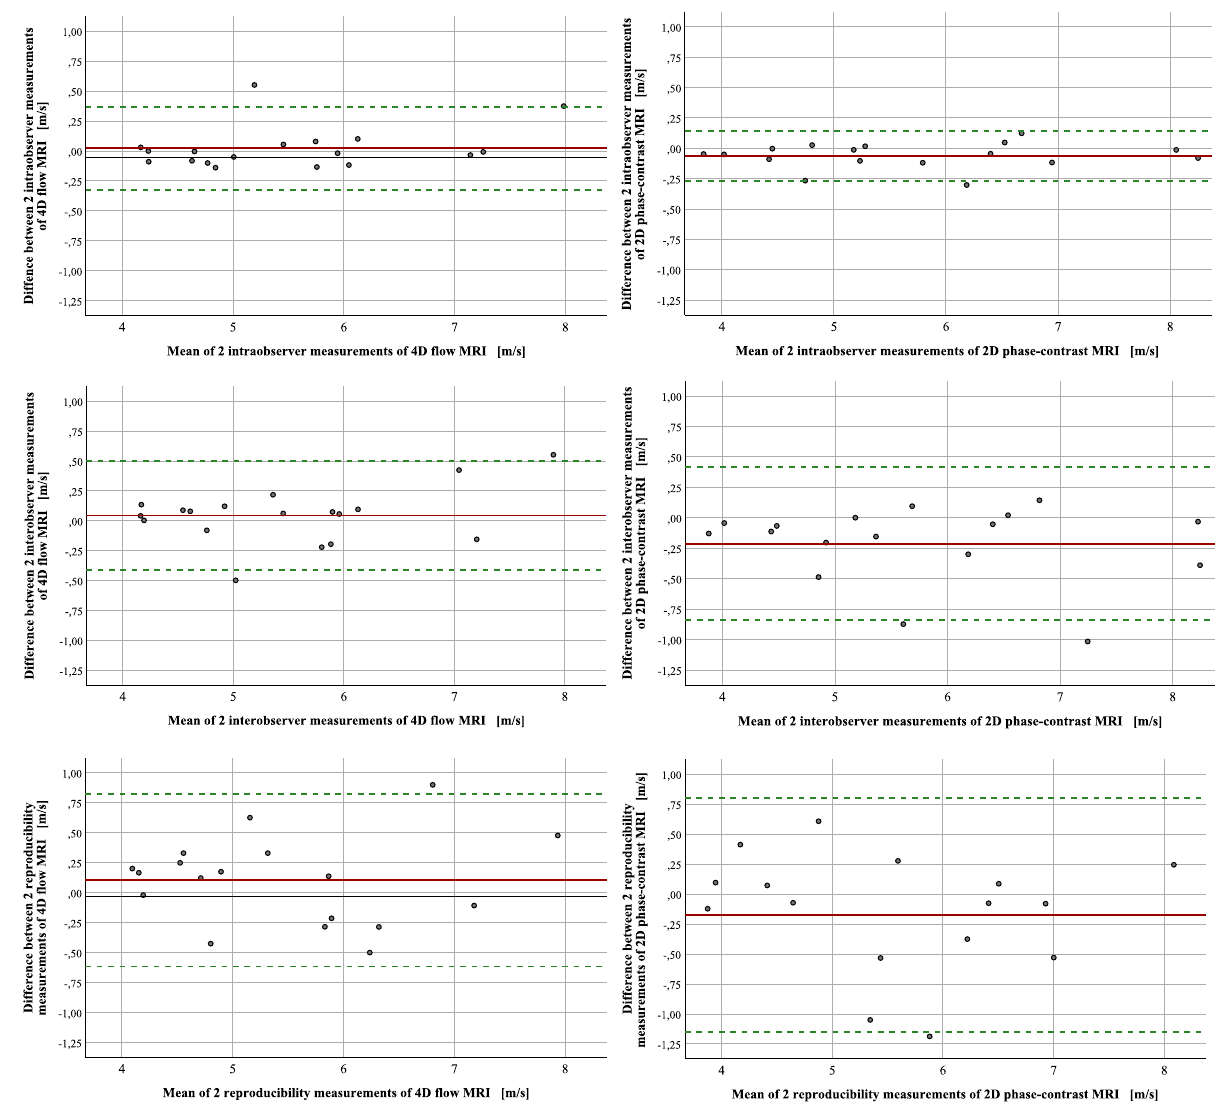
Figure 6. Measurement accuracy of PWV based on 4D flow and 2D phase-contrast MRI. Mean difference (solid line) ± 1.96 × standard deviation (dashed lines) is shown. Intra-observer agreement of 4D flow MRI (left column, n = 18) was 0.02 m/s [−0.32; 0.37], inter-observer agreement of 4D flow MRI was 0.04 m/s [−0.41; 0.5] and reproducibility of 4D flow MRI was 0.1 m/s [−0.62; 0.82]. Intra-observer agreement of 2D phase-contrast MRI (right column, n = 17) was −0.06 m/s [−0.27; 0.15], inter-observer agreement of 2D phase-contrast MRI was −0.21 m/s [−0.84; 0.42] and reproducibility of 2D phase-contrast MRI was −0.17 m/s [−1.15;